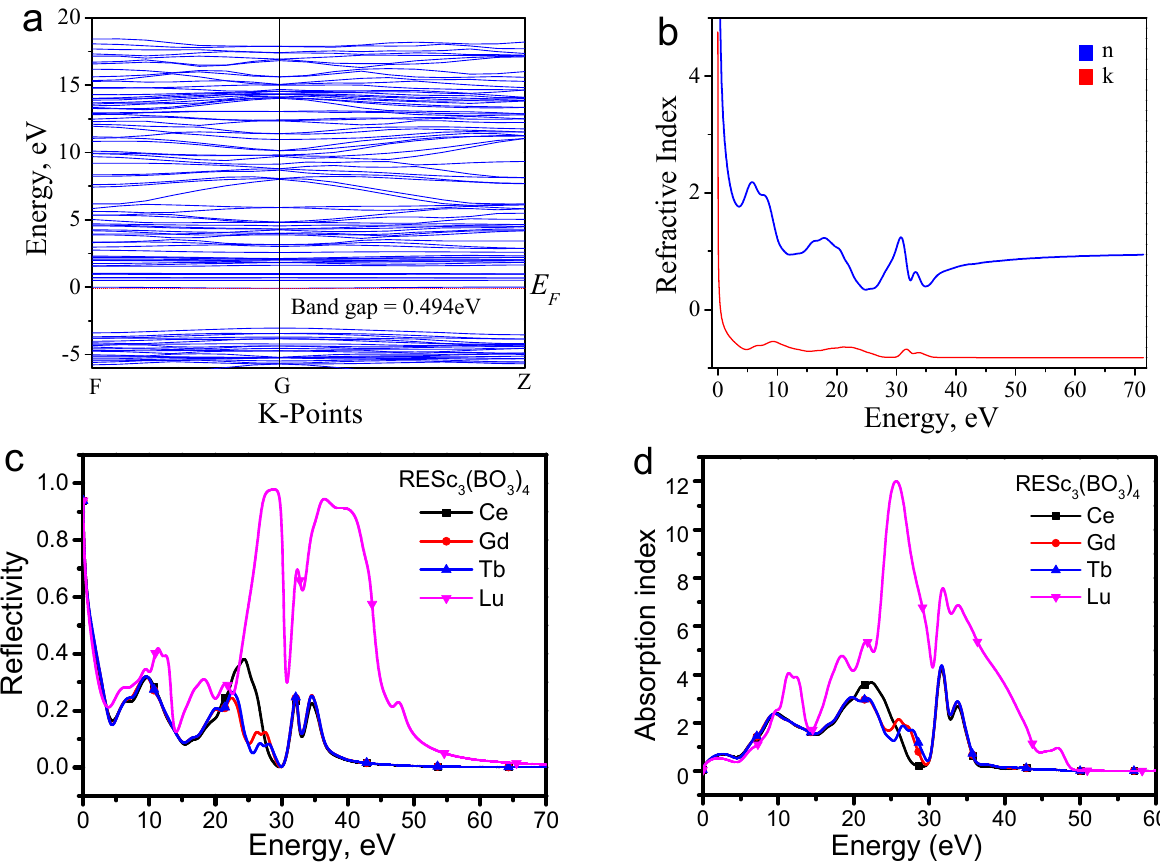
Figure 6. Theoretical calculation results. ( a ) The band gap of CeSc 3 (BO 3 ) 4 , ( b ) the refractive index of CeSc 3 (BO 3 ) 4 , ( c ) the reflection spectra of RESc 3 (BO 3 ) 4 , and ( d ) the absorption spectra of RESc 3 (BO 3 ) 4 (RE = Ce, Gd, Tb, Lu).